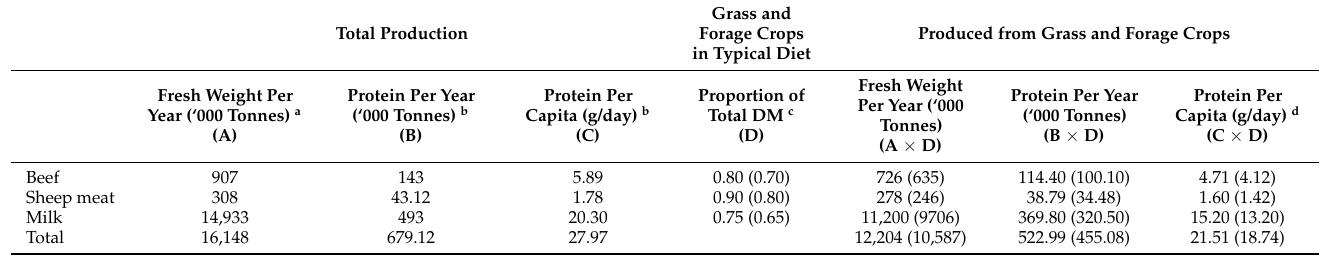
a From Table 1. b From Table 2. c From Wilkinson, 2011 [35]. Parenthesised values assume that the proportion